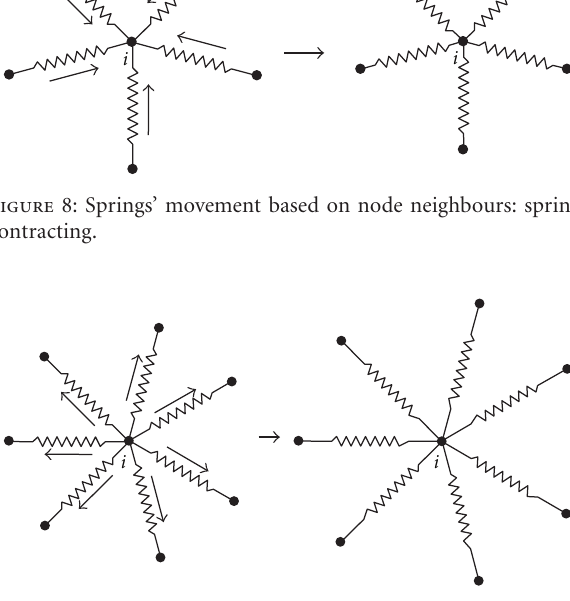
Figure 9: Springs’ movement based on node neighbours: springs